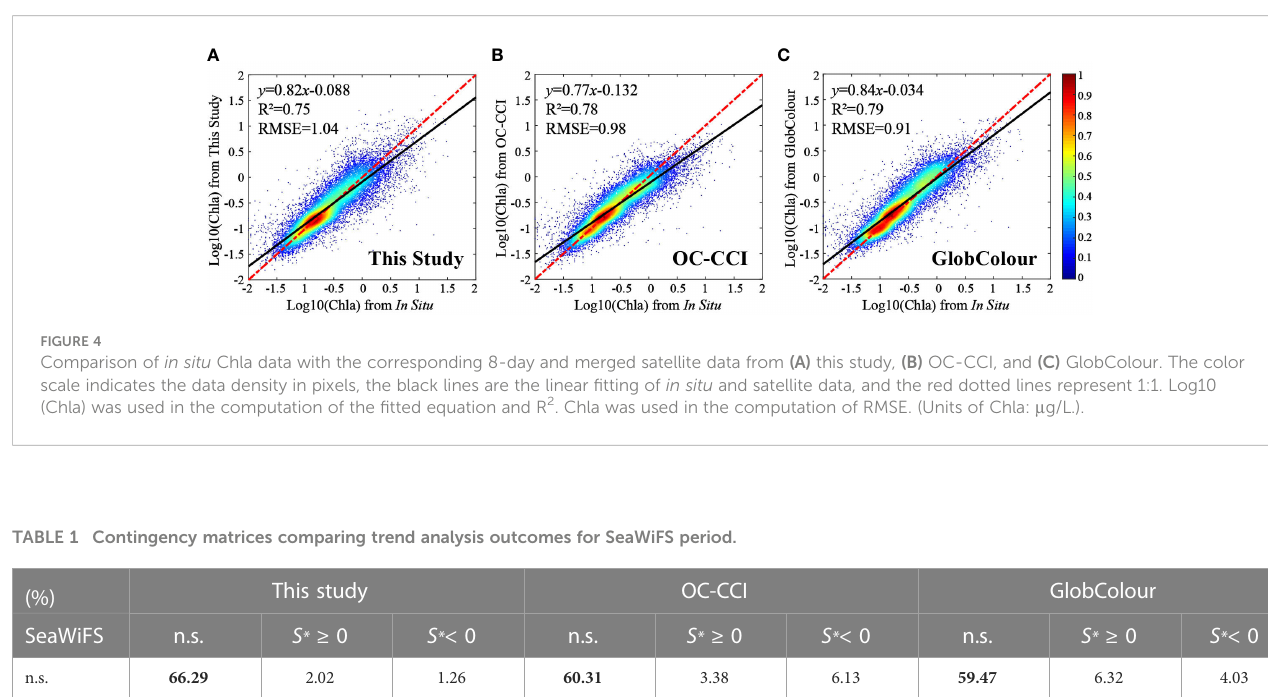
(%) This study OC-CCI GlobColour SeaWiFS n.s. S * ≥ 0 S * < 0 n.s. S * ≥ 0 S * < 0 n.s. S * ≥ 0 S * < 0 n.s. 66.29 2.02 S* ≥ 0